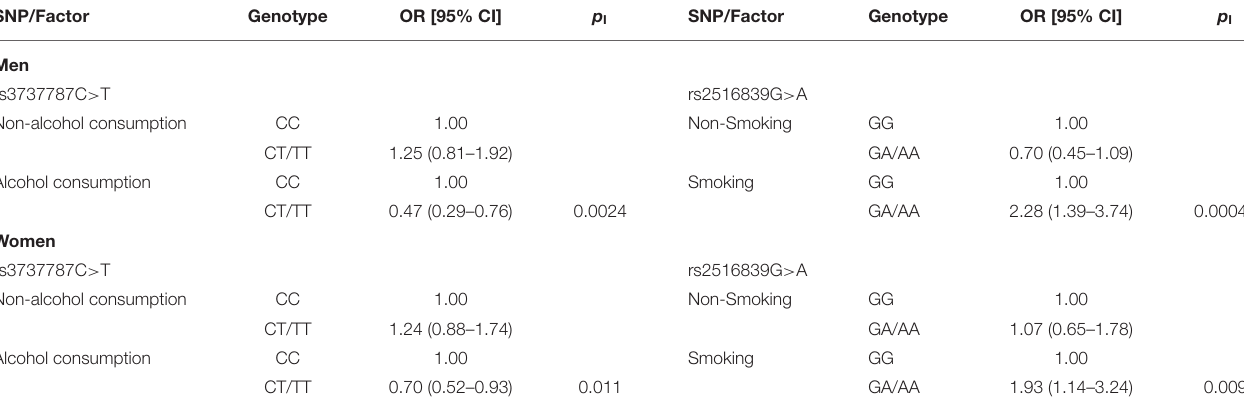
TABLE 9 | Interactions of the genotypes and smoking/alcohol consumption on the risk of EOCAD. SNP/Factor